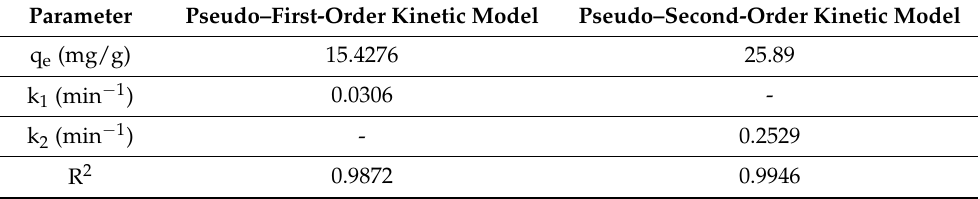
Table 1. Biosorption kinetic parameters of CPX on Saccharomyces cerevisiae /calcium alginate beads.